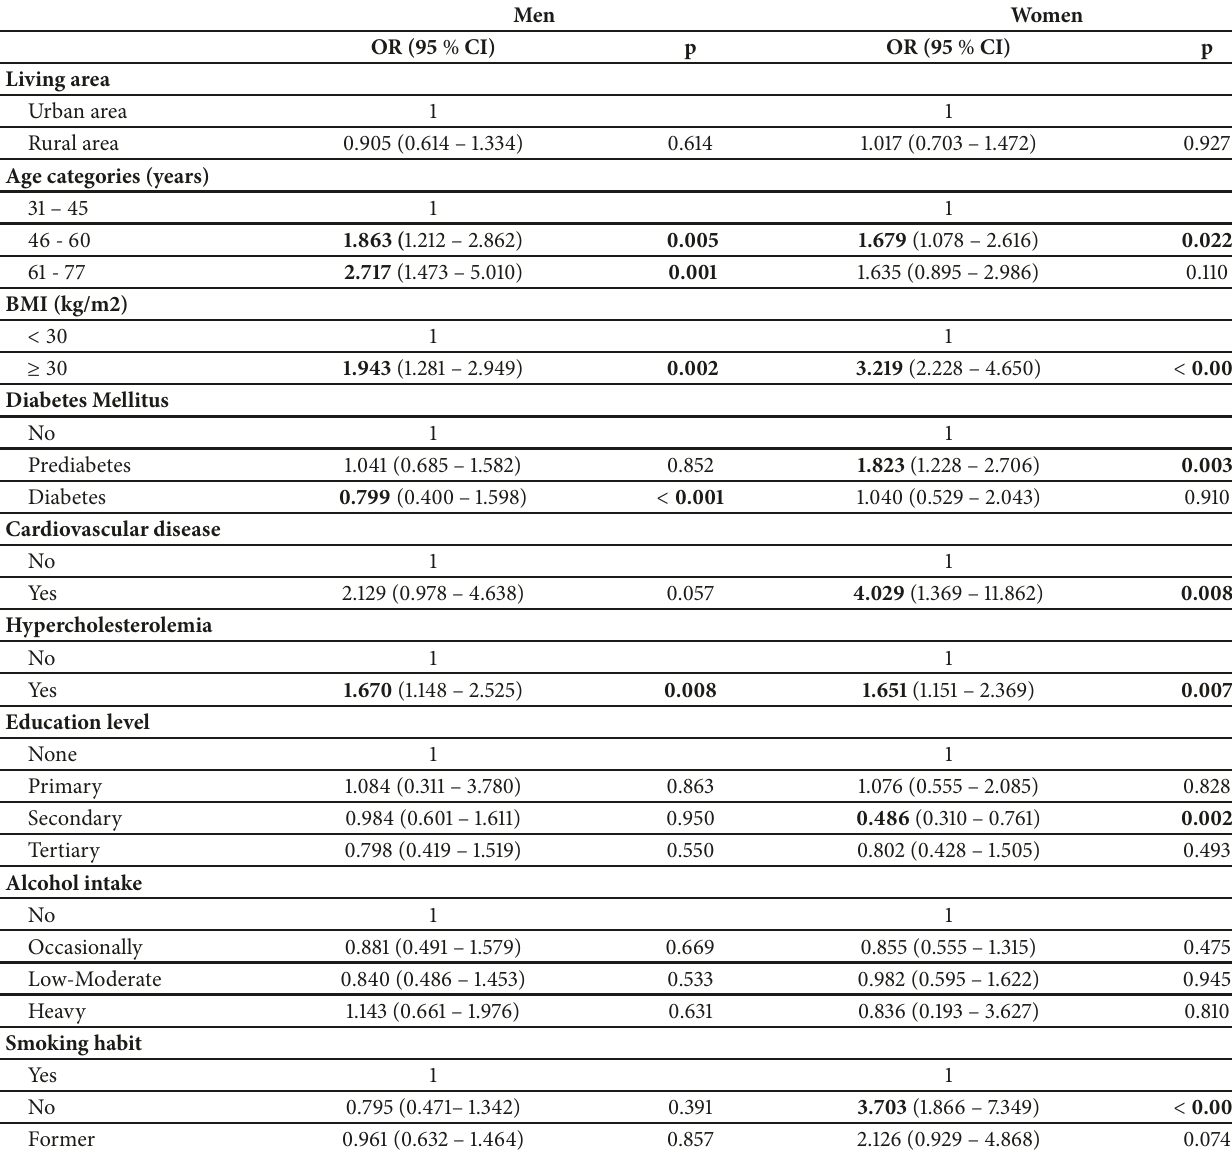
Table 3: Multiple logistic regression analysis of subjects’ probability of being hypertensive after adjusting for age, body mass index, diabetes, cardiovascular disease, hypercholesterolemia, education level, alcohol, and smoking